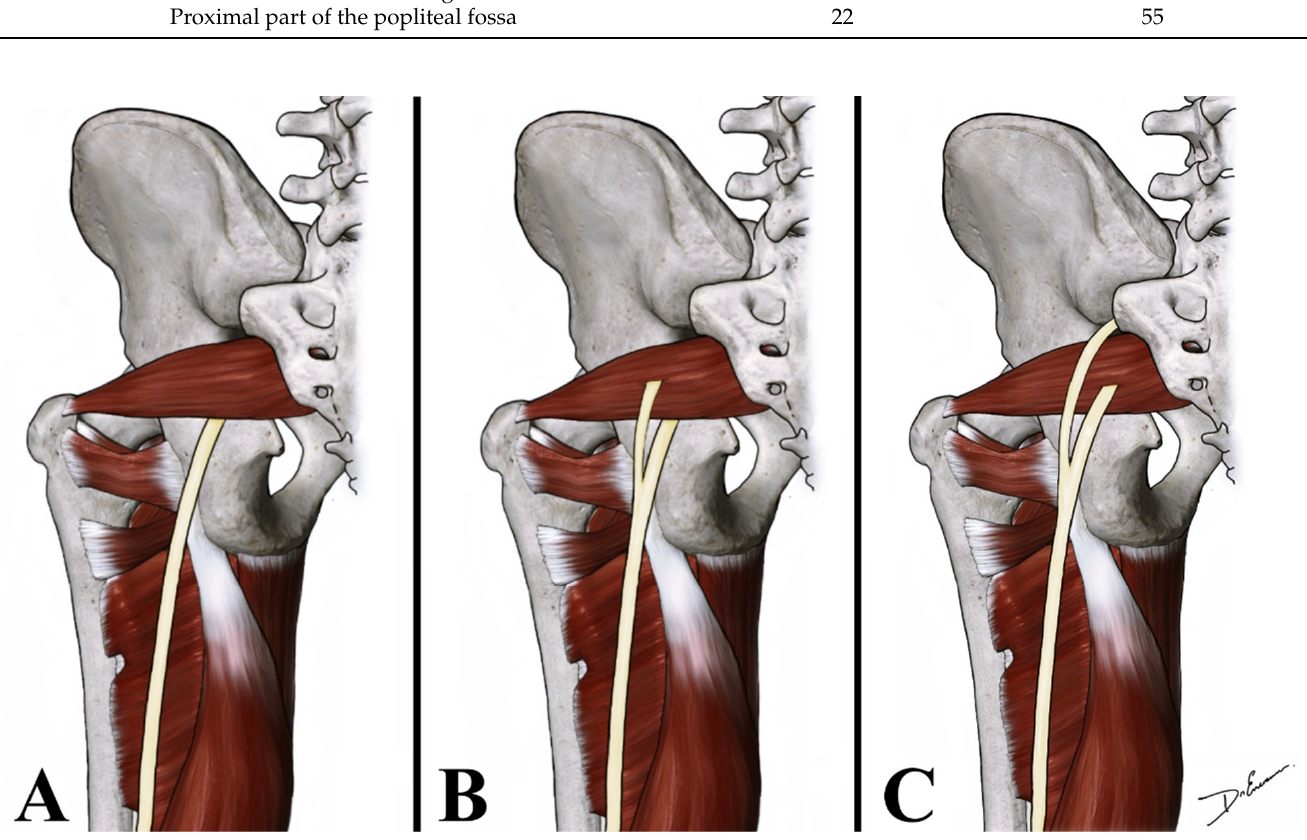
Figure 2. It shows a right deep gluteal and right posterior femoral region. After gluteal major muscle retraction (1), the PM (2) and the SN (3) are visible. The SN exit inferior to the PM, dividing into the tibial nerve (4) and the common peroneal nerve (5).